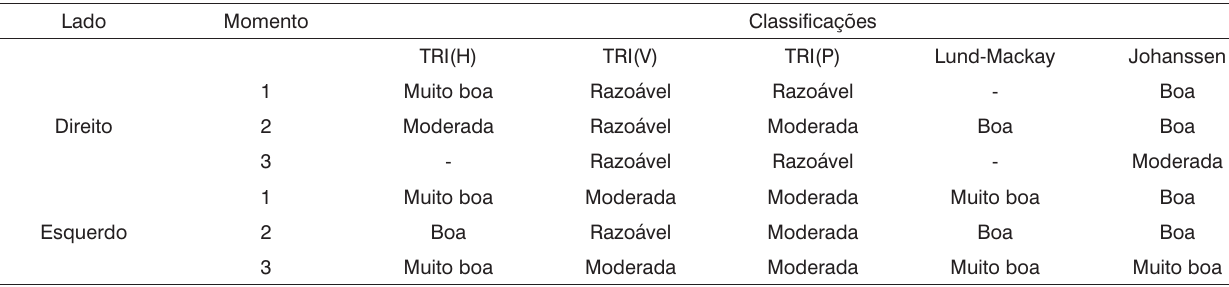
Tabela 3. Avaliações das concordâncias entre os